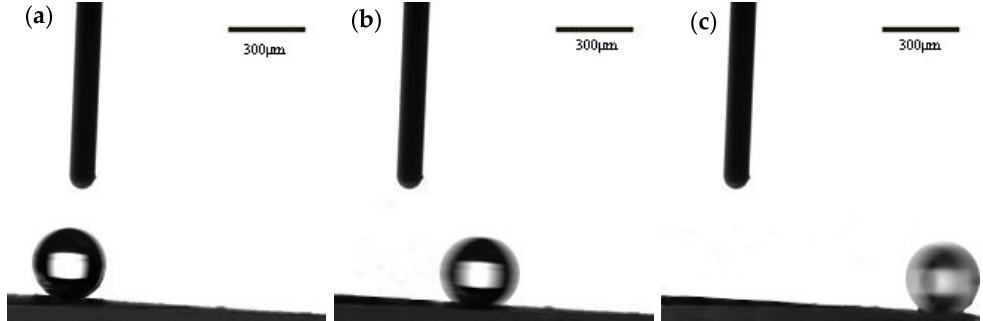
Figure 8. Wettability of water droplets on the surface of the membrane. ( a ) Untreated copper mesh; ( b ) As-prepared copper mesh.